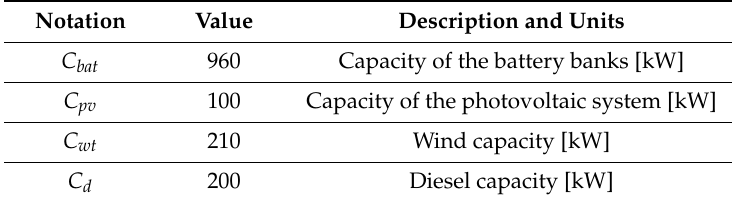
Table 2. Power sources capacities (for F 1 ( x ), F 2 ( x ), F 3 ( x ), and F 4 ( x ) calculation).